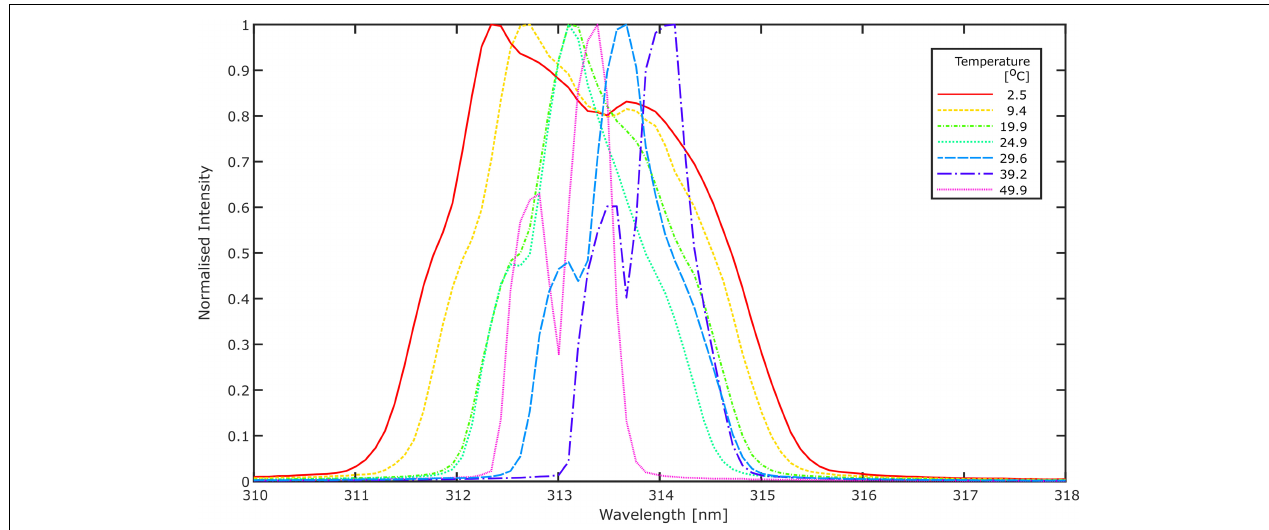
FIGURE 4 | Normalized instrument line shapes for a number of temperatures displayed in Figure 3 . At low temperatures the line shape becomes quite broad, possibly preventing DOAS retrievals from being performed. Toward higher temperatures a double peak begins to form.